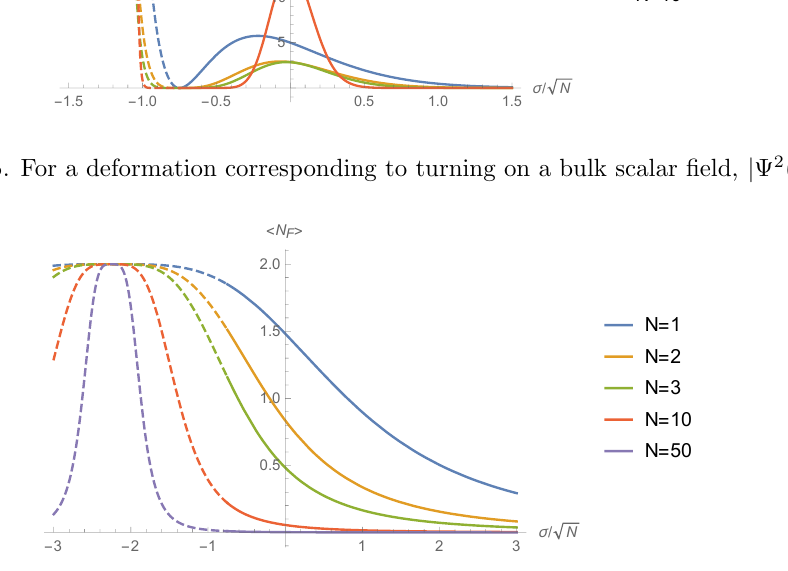
N = 1, j (cid:9) j 2 can be seen in (cid:12)gure 5. We see that for small deformation, there is a